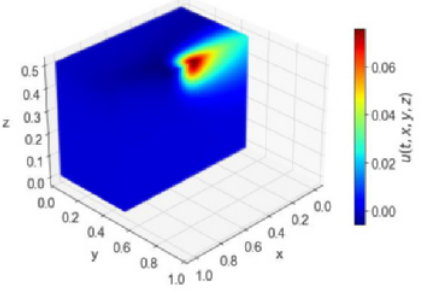
Fig. 2. 3D-temperature profile (cid:8)((cid:2)⃗, (cid:9)) at a given time during and after the passage of a laser focus through model material.